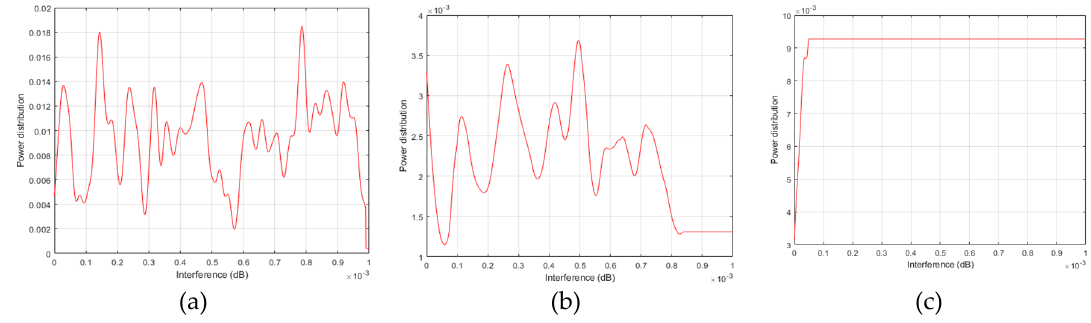
Figure 7. Power distributions at varying time instances with equilibrium evolution, (a) T = 2 s, (b) T = 3.5 s, (c) T = 5 s.